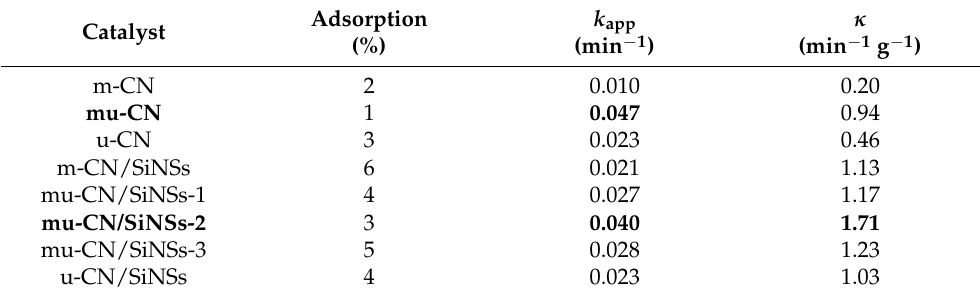
Table 4. Photocatalytic performance of the CNs and CN/SiNSs composites towards TC